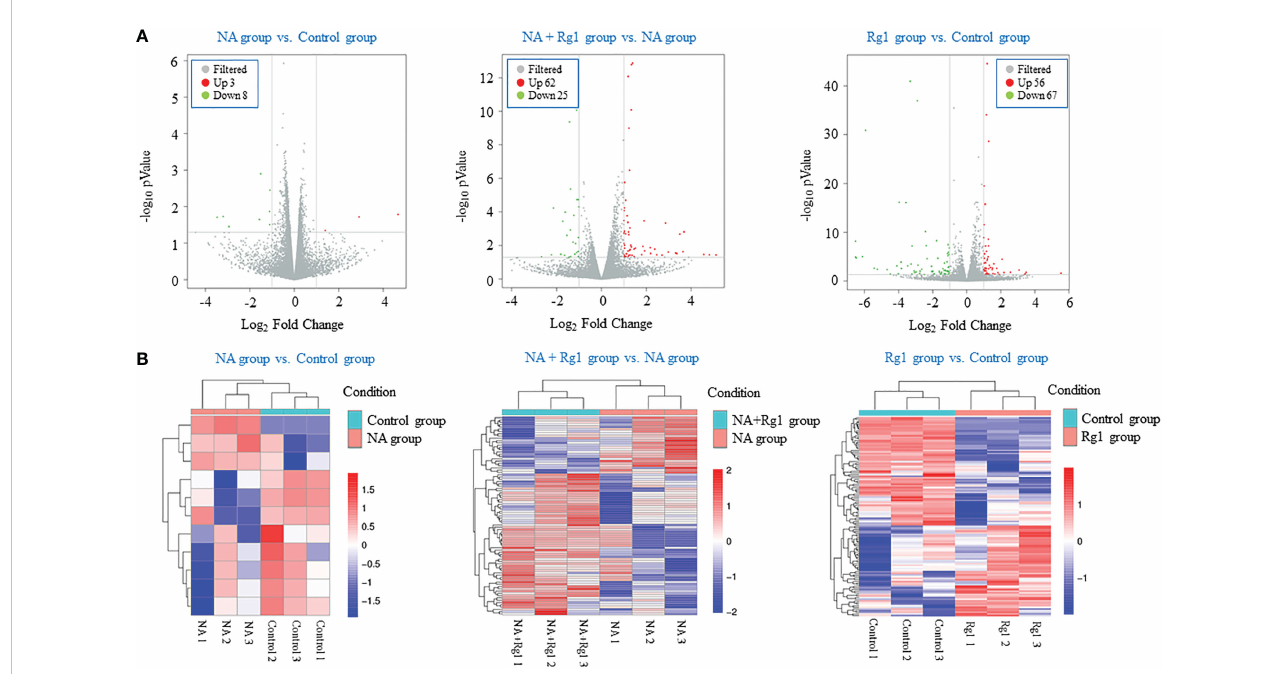
FIGURE 4 Transcriptome analysis of the effects of noradrenaline (NA) and ginsenoside Rg1 on the gene expression of granulocyte from healthy humans. (A) Volcano plot of data comparison between different groups. Every dot represents a differentially expressed gene. Gray represents no signi fi cant difference in gene expression between the two groups. Red represents signi fi cantly upregulated gene expression. Green represents signi fi cantly downregulated gene expression. (B) Clustering analysis of differentially expressed genes between different groups. Red represents upregulated genes. Blue represents downregulated genes. The depth of different colors represents different levels of gene